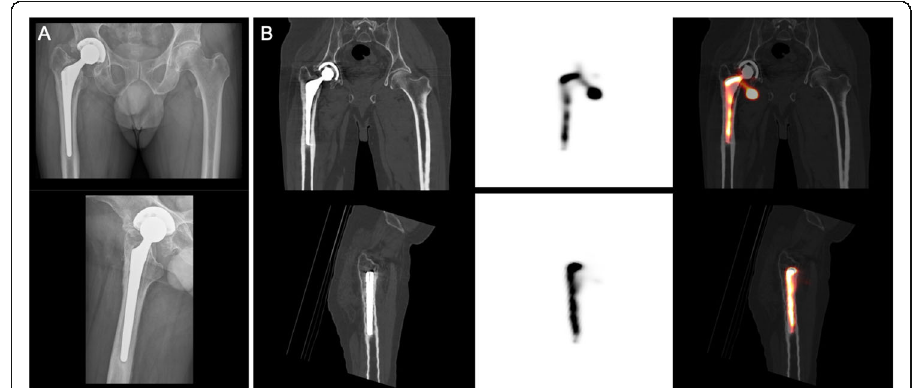
Fig. 4 Femoral component loosening of a right hip total arthroplasty. The radiograph images demonstrate lucency along the metal-bone interface (first column). Coronal (top) and sagittal CT (second column), SPECT (third column), and fused SPECT/CT (fourth column) images showing abnormal tracer activity along the